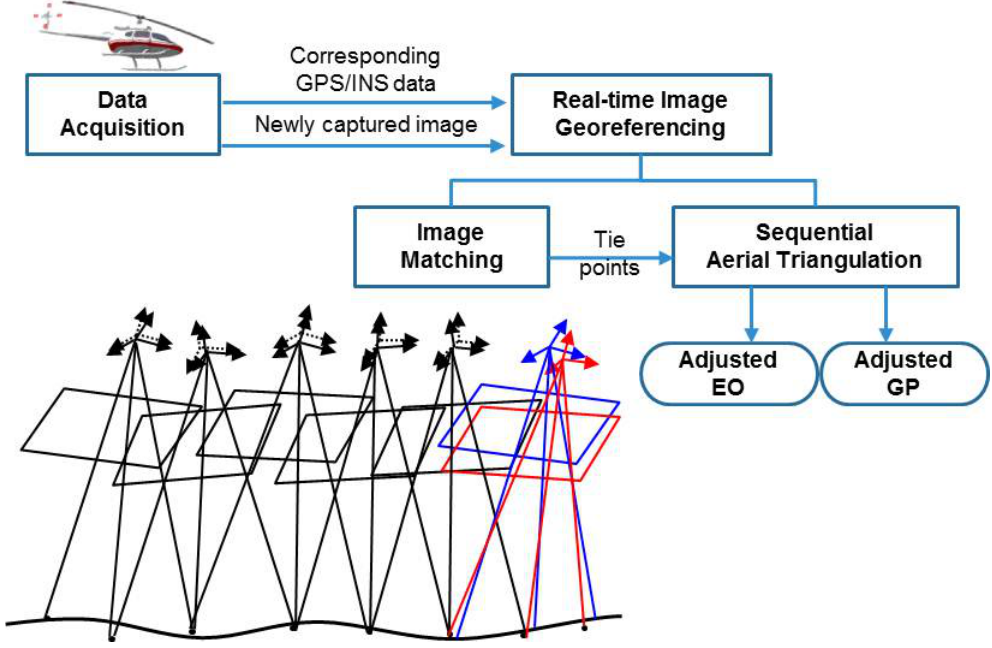
Figure 1. Real-time image